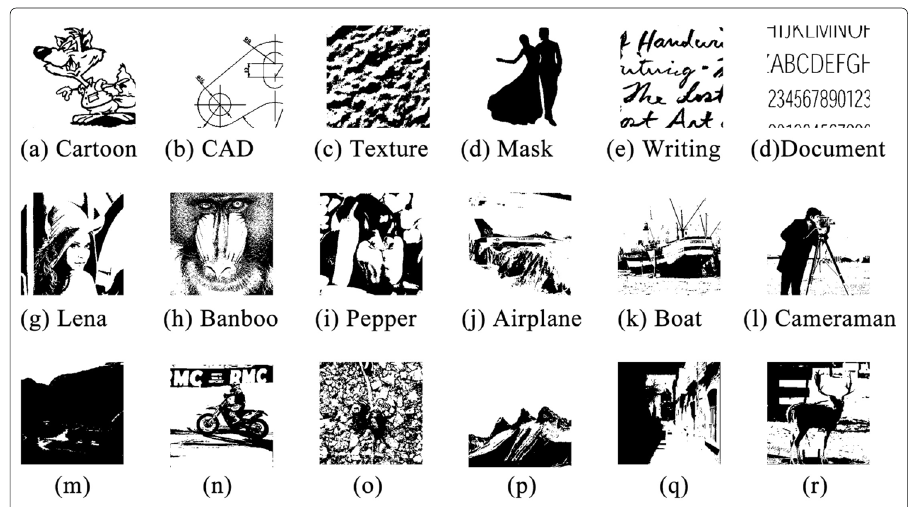
Fig. 6 The experimental binary images from different image sources. The first row contains some classical binary images, the second row presents the binary images converted by some classical grayscale image, and the third row shows the binary images converted by a large-scale classical gray image database, BOSSBase v1.01